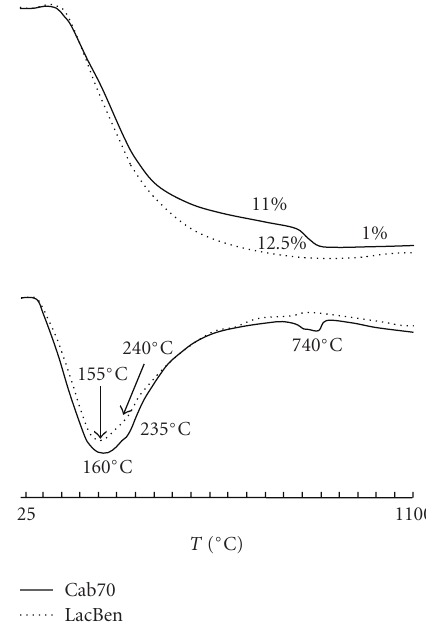
Figure 3: DTA and TG curves of Cab70 and LacBen